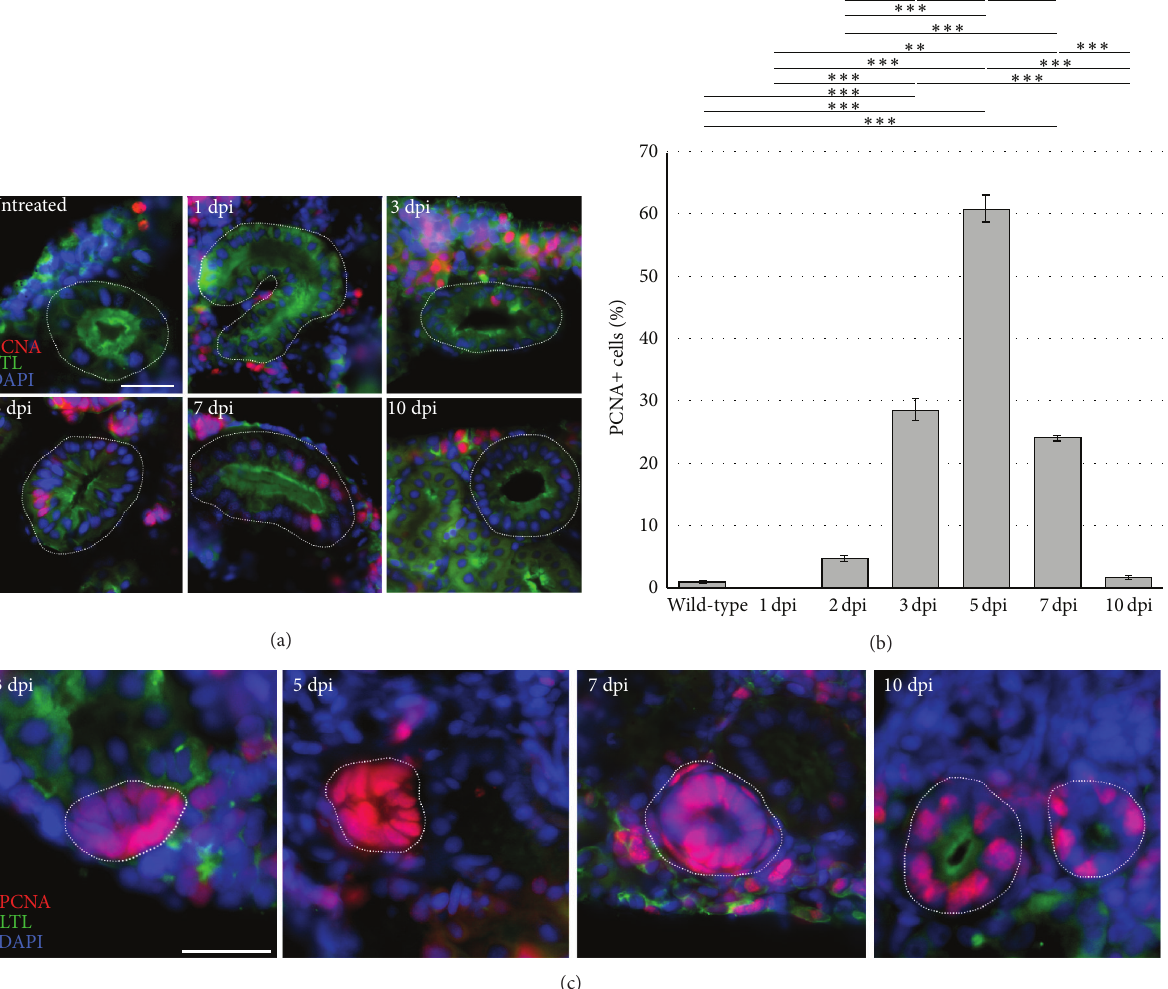
Figure 5: Cell proliferation in the regenerating proximal tubule epithelium and in neonephrogenic clusters. Kidney tissue was assayed for PCNA-positive nuclei (red), and proximal tubules were identified by LTL labeling (green). Nuclei were stained with DAPI (blue). (a) Most epithelial proliferation occurred at 3, 5, and 7 days after kidney injury. Scale bar, 25 𝜇 m. (b) Quantification of PCNA expression in nephron proximal tubular segments. Labels: ∗∗ indicates 𝑃 < 0.01 ; ∗ ∗ ∗ indicates 𝑃 < 0.001 . (c) Epithelial proliferation marked by PCNA (red) occurred at high levels in cellular aggregates at 3 and 5 dpi. At 7 dpi, aggregates that have formed lumens continued to express intense levels of PCNA. At 10 dpi, PCNA was still abundant in tubules that have become LTL-positive (green).